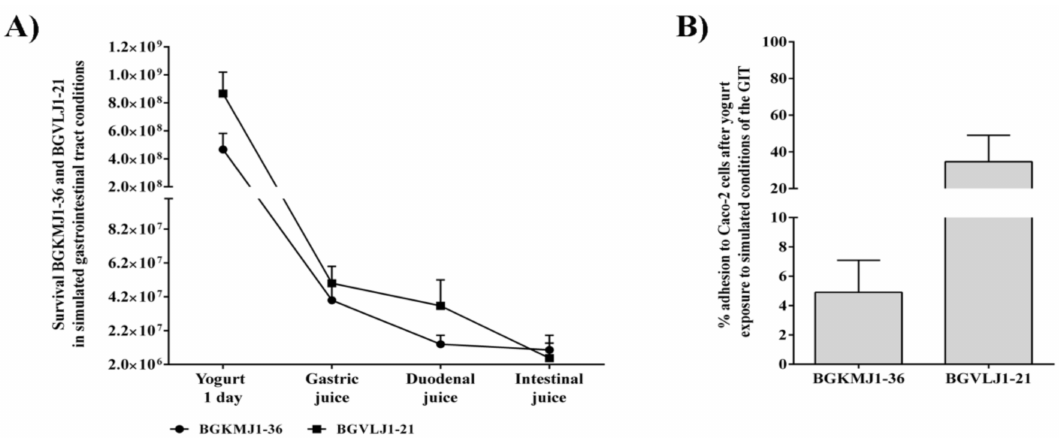
Figure 2. Survival of Streptococcus thermophilus BGKMJ1-36 and Lactobacillus bulgaricus BGVLJ1-21 in simulated gastrointestinal tract and adhesion to Caco-2 cells after exposure to last phase (intestinal juice) of simulated gastrointestinal tract conditions. ( A ) Survival of BGKMJ1-36 and BGVLJ1-21 in yogurt one-day-old after exposure to simulated gastrointestinal tract (GIT). Gastric juice (pH = 2.0) contained pepsin 0.3%, duodenal juice (pH = 8.0) contained 1% bile salts, while intestinal juice (pH = 8.0) contained 0.3 % bile salts and pancreatin 0.1%; ( B ) adhesion of BGKMJ1-36 and BGVLJ1-21 from yogurt one-day-old after exposure to simulated gastrointestinal tract to Caco-2